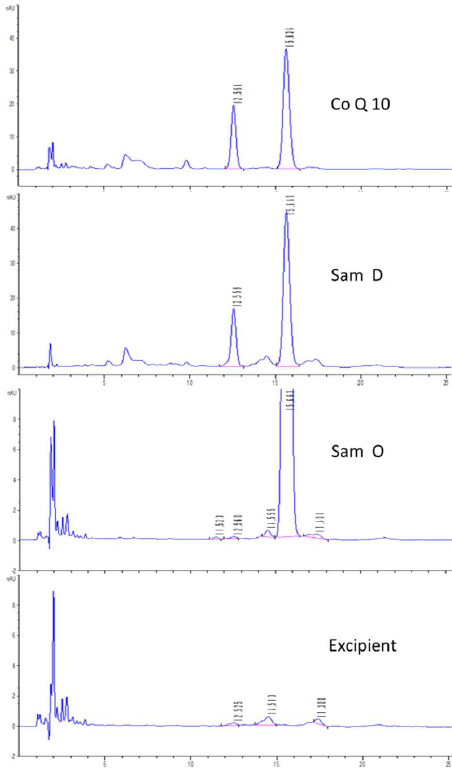
Figure 1. Typical chromatogram of the confirmation.